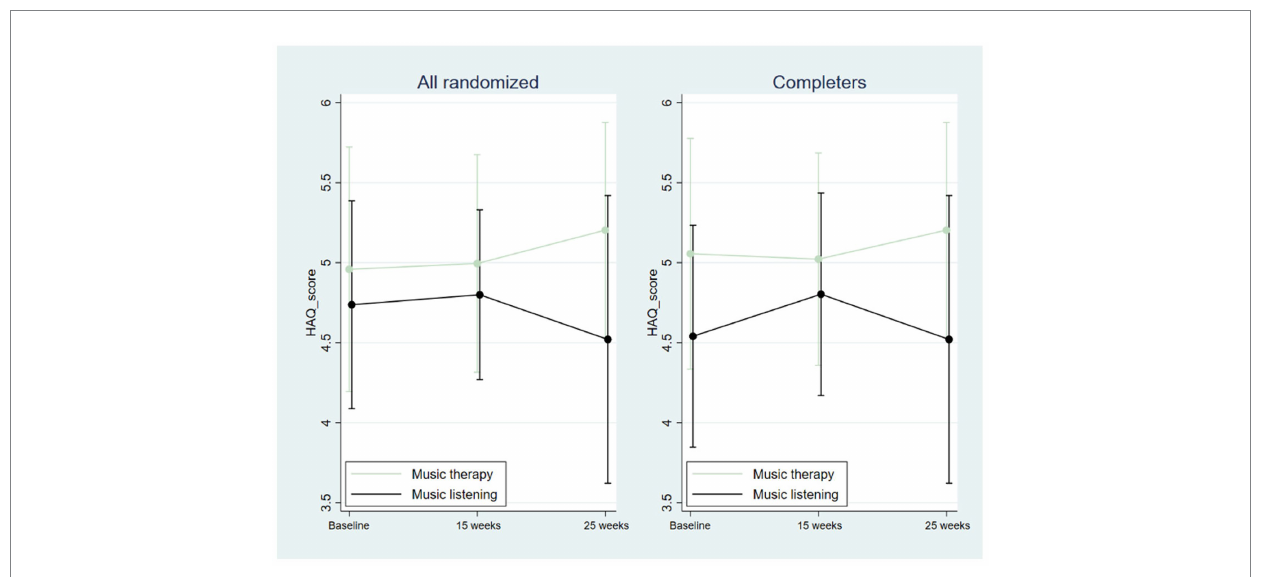
FIGURE 4 Helping alliance (Haq-II) scores. Vertical lines indicate standard